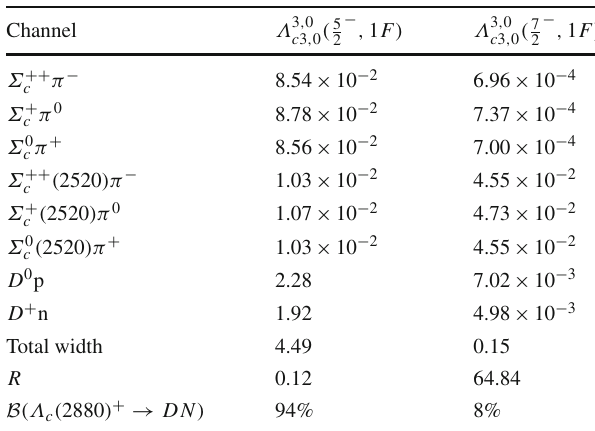
of Λ c ( 2880 ) + as Λ 2 , 0 c ( 2455 )π)